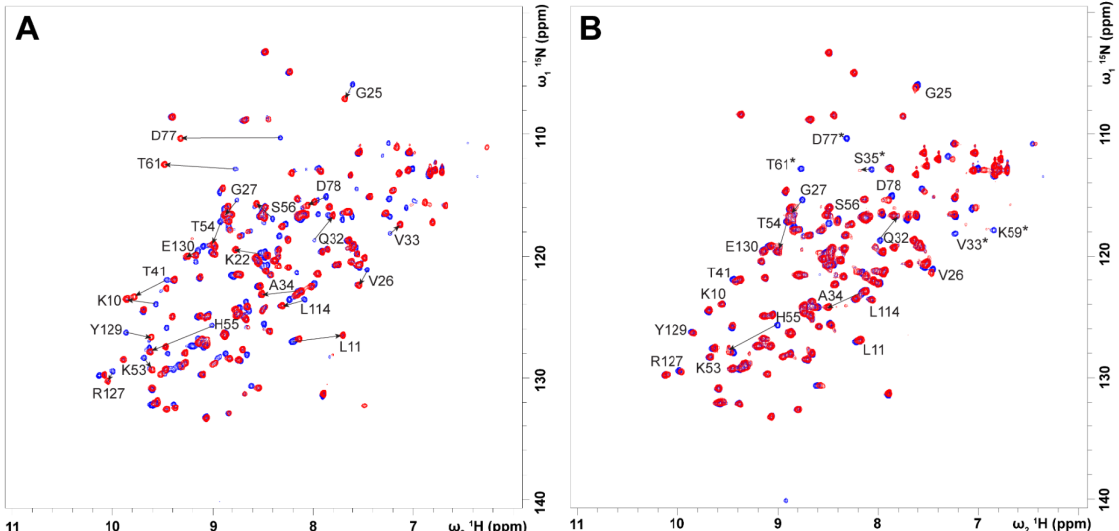
Figure 4. Superposition of the 2D 1 H- 15 N HSQC spectra for ( A ) heart-type fatty acid-binding protein (FABP3)-C18:1(n-9) t and ( B ) FABP3-C18:1(n-9) t -carnitine complex in 20 mM K 2 HPO 4 /KH 2 PO 4 , 50 mM KCl buffer pH 7.6 (KPi). The spectrum of apo-FABP3 — in blue, spectrum of the FABP3-ligand complex — in red. Residues with chemical shift perturbations (CSPs) larger than the mean plus one standard deviation are assigned and black arrows show the shift of the corresponding crosspeak. * marks the crosspeaks that have disappeared upon binding of the acylcarnitines (ACs). Binding of the ACs caused much smaller changes in the crosspeak positions of